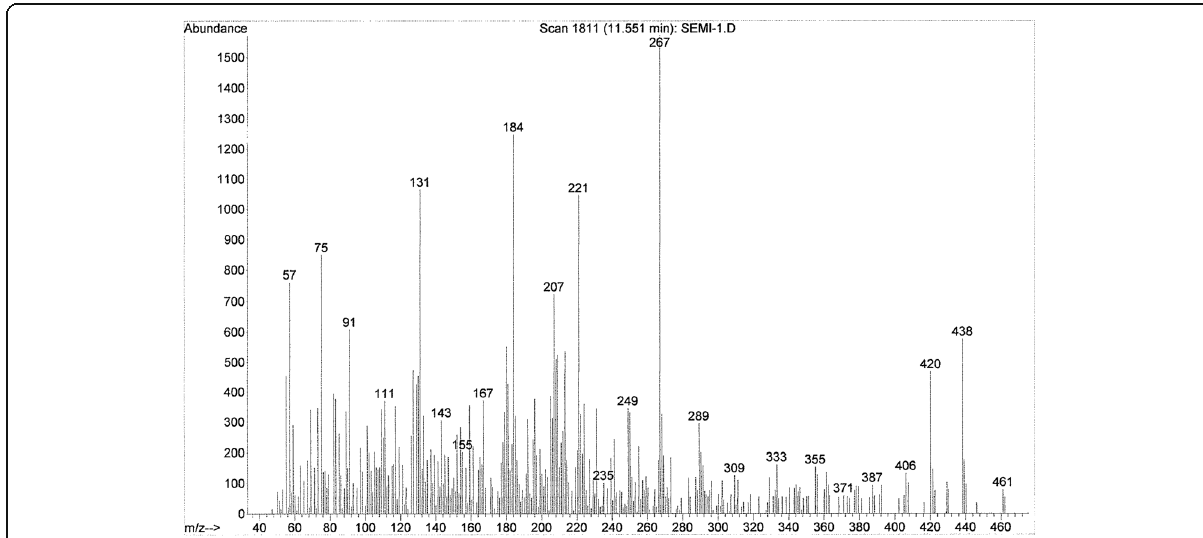
Fig. 5 Mass spectrum LSA from seed